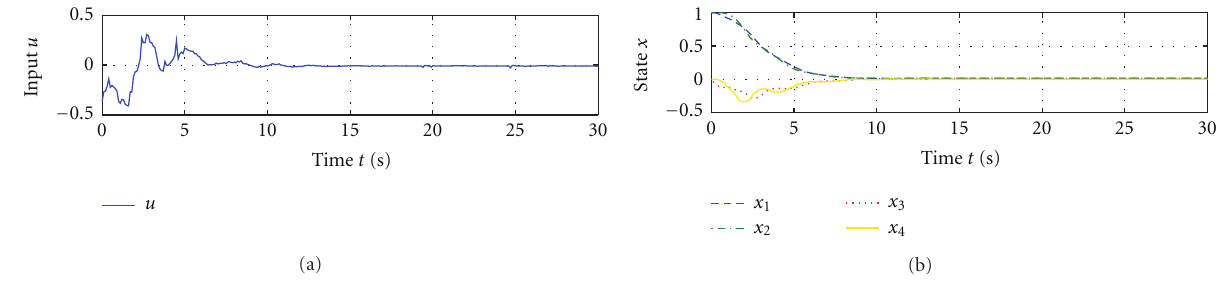
Figure 5: Closed-loop response of the coupled spring-mass system with γ 2 = 4.